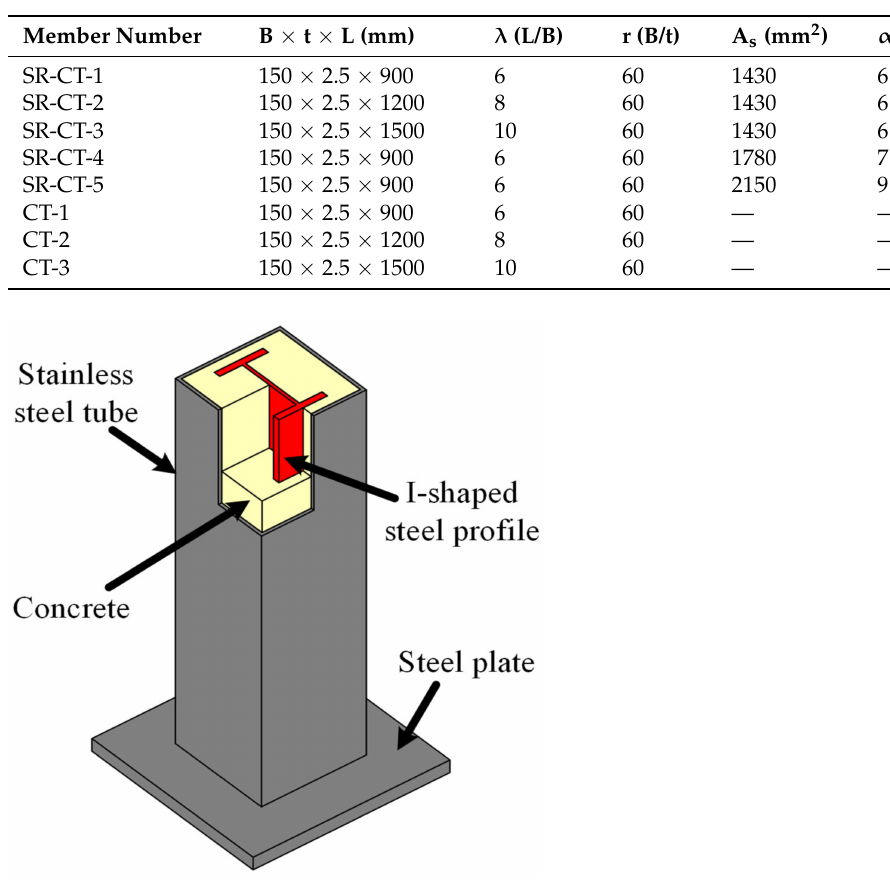
Table 1. Component design parameters.